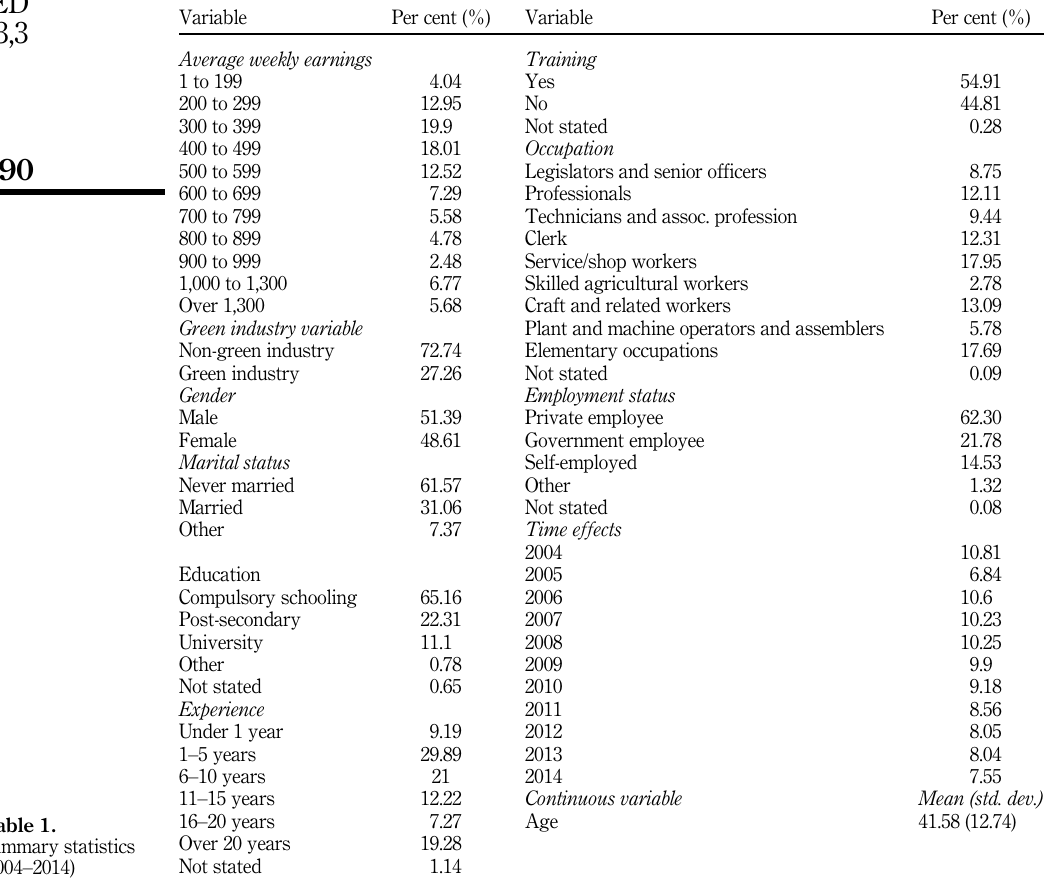
Table 1. Summary statistics (2004 –